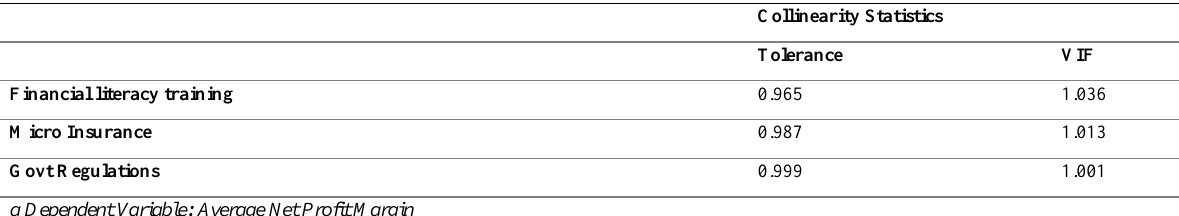
Table 3: Collinearity